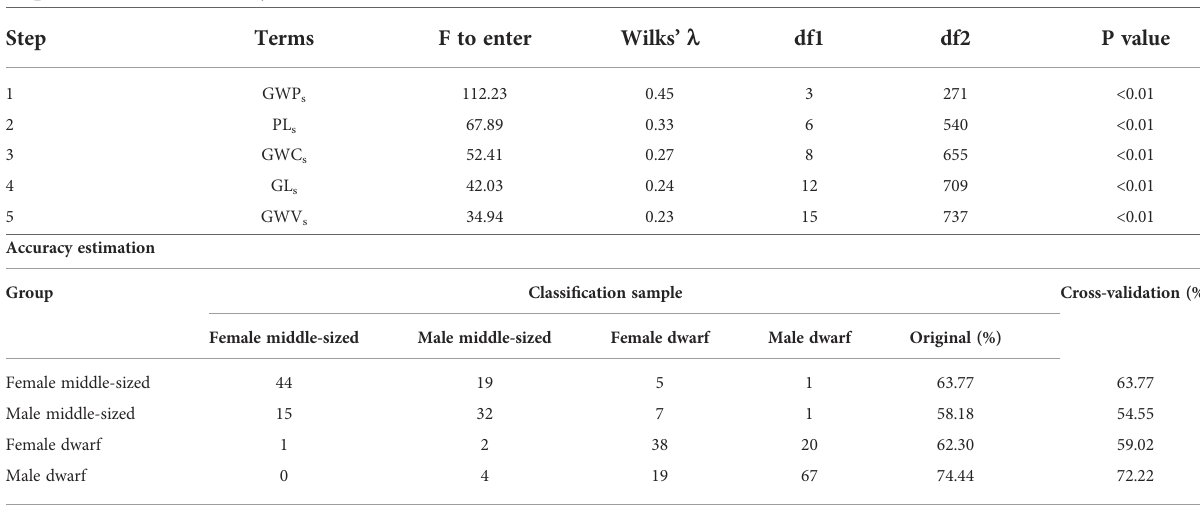
TABLE 4 The result of stepwise discriminant analyses for gladius morphometric characteristics of female and male dwarf without a dorsal photophore and middle-sized typical forms Sthenoteuthis oualaniensis in the South China Sea. Stepwise discriminant